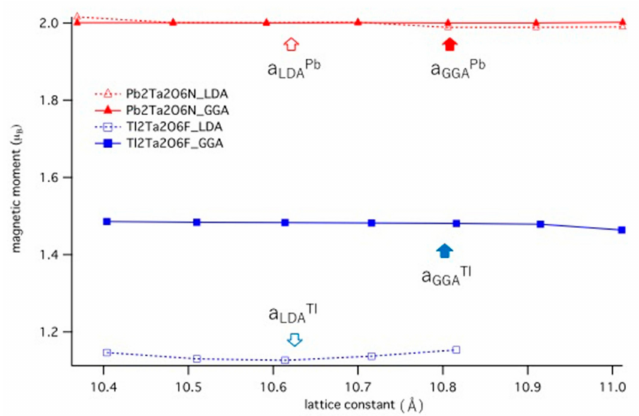
Figure 4. Calculated magnetic moment of Pb 2 Ta 2 O 6 N (triangles) and Tl 2 Ta 2 O 6 F (squares). Open markers are for LDA, and filled markers are for GGA. The arrows show the equilibrium lattice